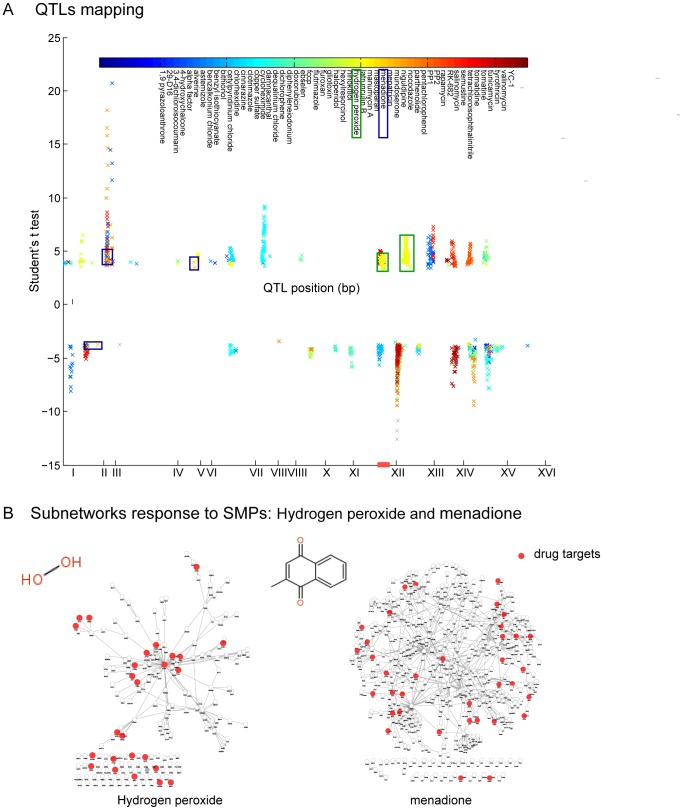
The QTLs distribution and drug targets enrichment of SMPs.(A) The QTLs distribution along the whole genome for 53 small-molecule drugs. QTLs associated with different SMPs are marked with various colors. (B) The sub-networks responding to the SMP response of hydrogen peroxide and menadione. Red nodes are known drug targets included in the STITCH database.